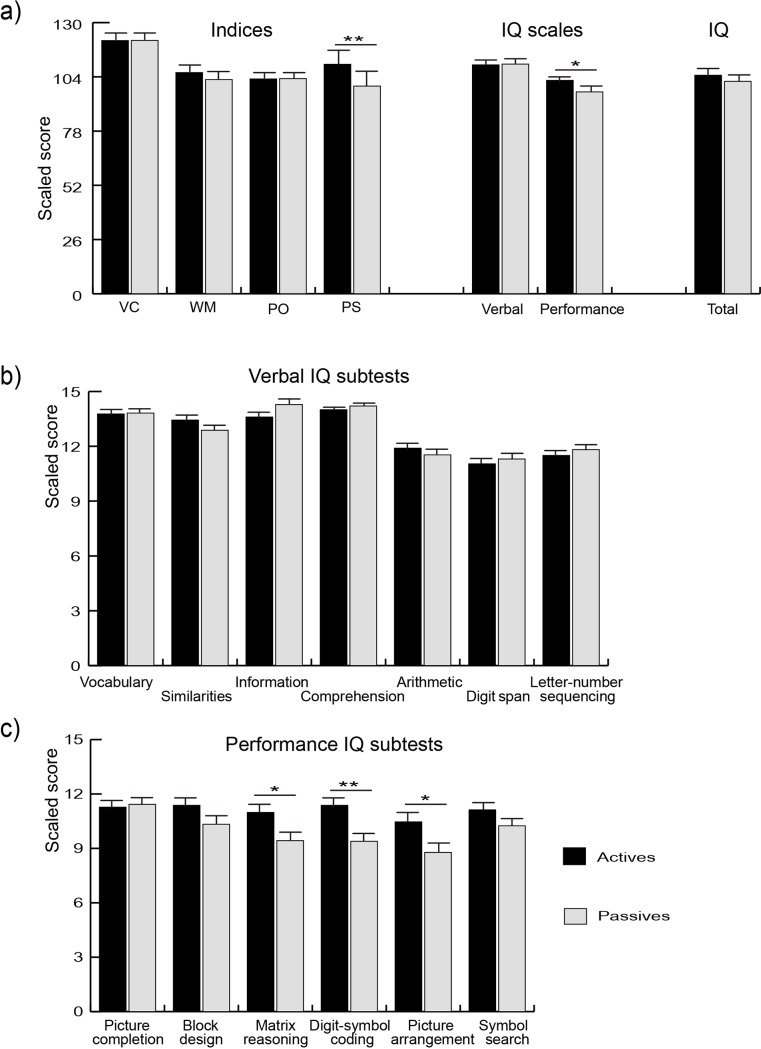
Comparisons between active (n = 48) and passive (n = 49) groups for the WAIS-III-R variables: a) Indices, IQ scales and total IQ; b) verbal WAIS subtests; and c) performance WAIS subtests; * p < .05; ** p < .01. IQ: Intelligence quotient; VCI: verbal comprehension index; WMI: working memory index; POI: perceptual organization index; PSI: processing speed index.